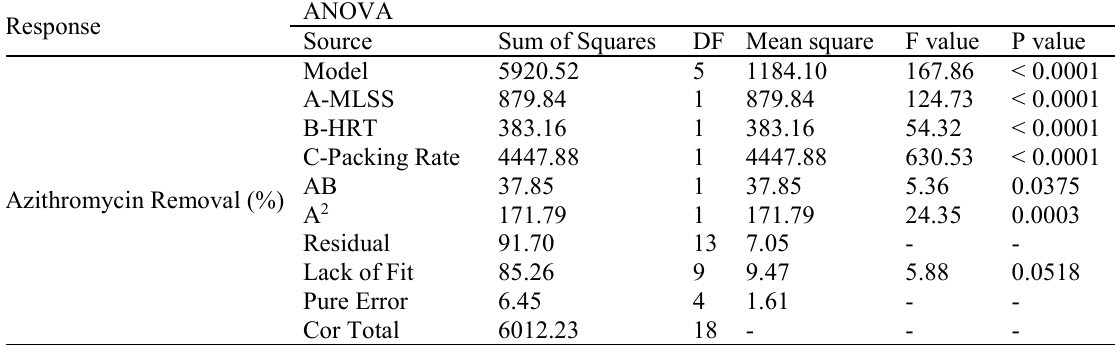
Table 4. ANOVA results on 2FI model for removal of azithromycin by MBBR